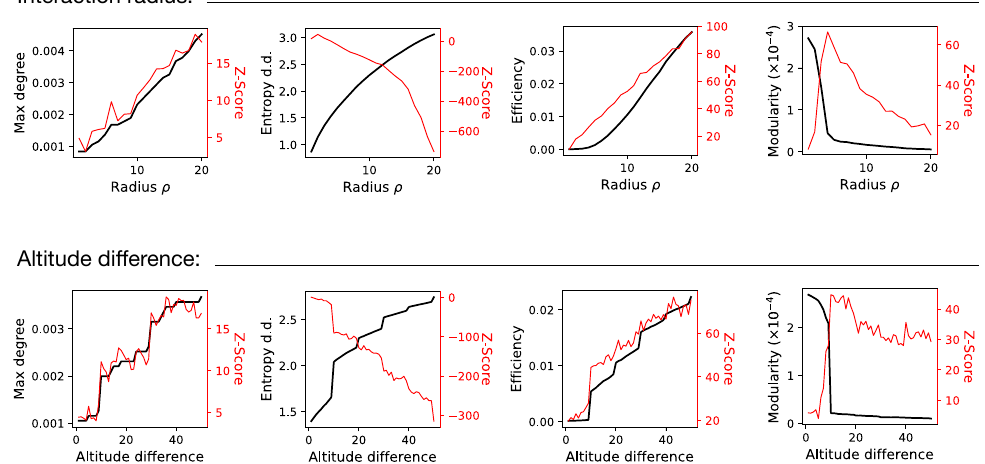
Figure 4. Properties of the interaction networks for the planned trajectories of 1 September 2018, as a function of the interaction radius ρ (in nautical miles, top panels) and the altitude difference (in hundreds of feet, bottom panels). See Figures A6 and A7 for full results. Black ( left Y axes) and red lines ( right Y axes), respectively, correspond to the raw values of the metrics and their